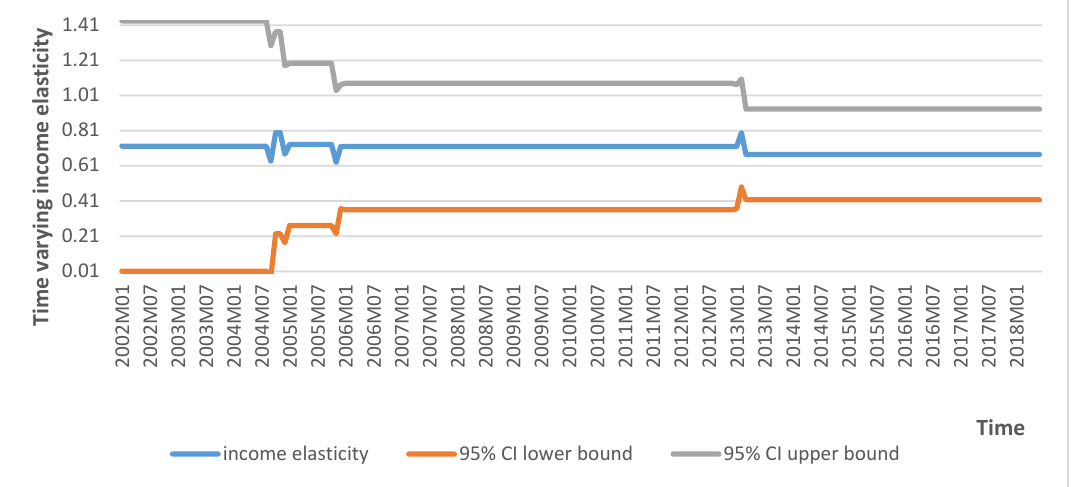
Figure 5. Time varying income elasticity: MIS result.